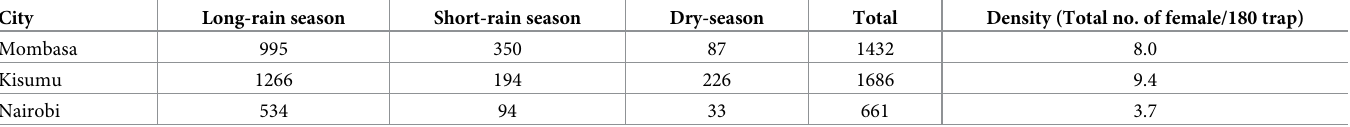
Table 1. Female Aedes aegypti mosquitoes collected seasonally using CO 2 -baited BG-Sentinel traps in Mombasa, Kisumu, and Nairobi between October 2014 and June 2016. City